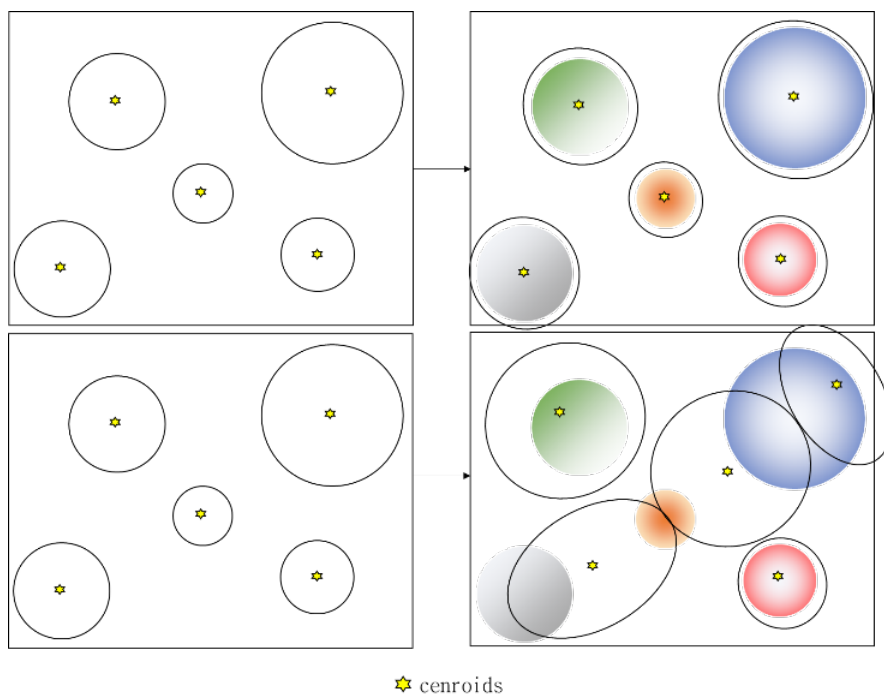
Figure 4. Examples of cluster changes according to centroids.